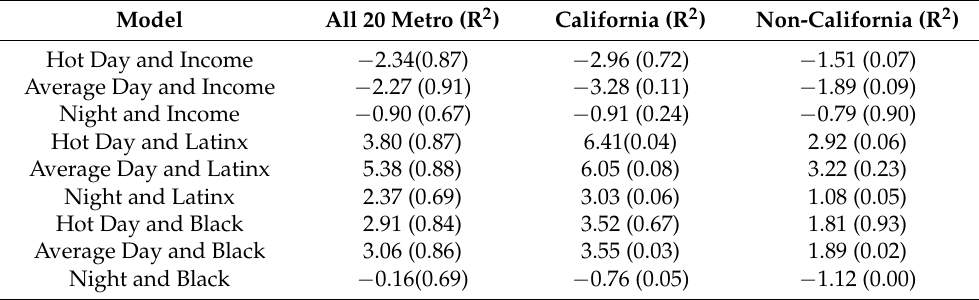
Table A1. Regression coefficients for the entire Southwest as well as just California. These values indicate the strength of the influence demographics has on surface